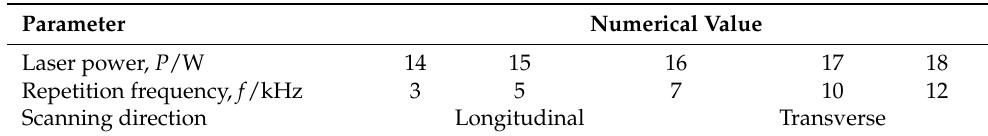
Table 2. Experiment parameters of nanosecond laser grooving (experiment 2, high energy den- sity grooving).